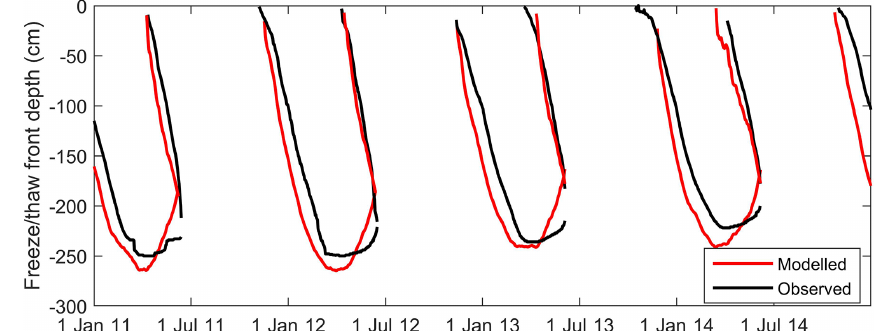
Figure 9. Comparison between simulated freeze/thaw depth by Stefan equation and